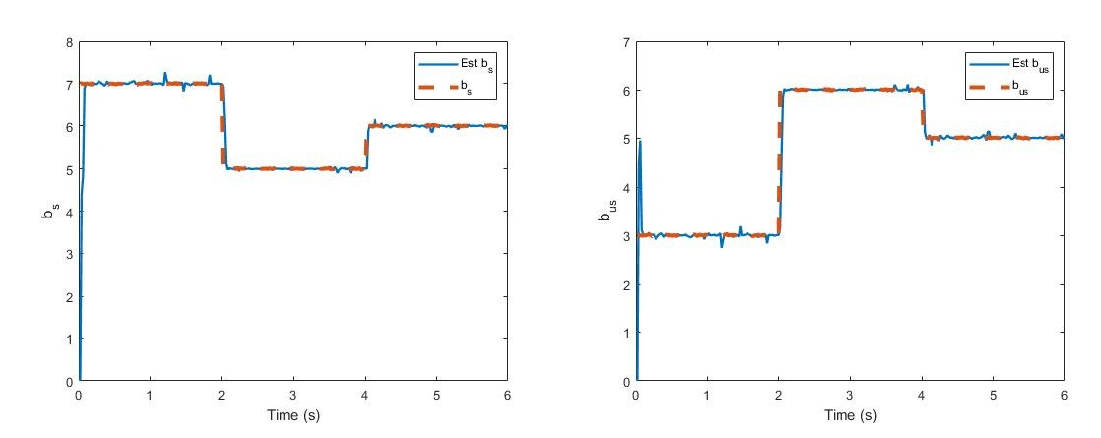
Figure 9. Parameter estimation